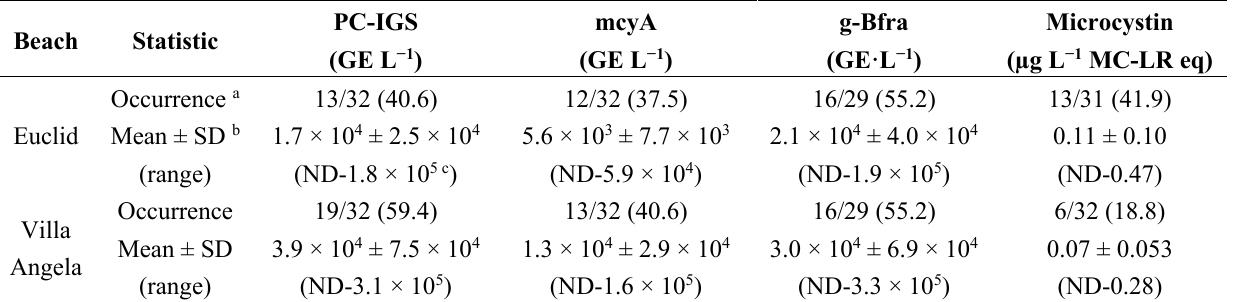
Table 2. Occurrence, means, and range of genetic marker densities and microcystin concentrations at Euclid and Villa Angela